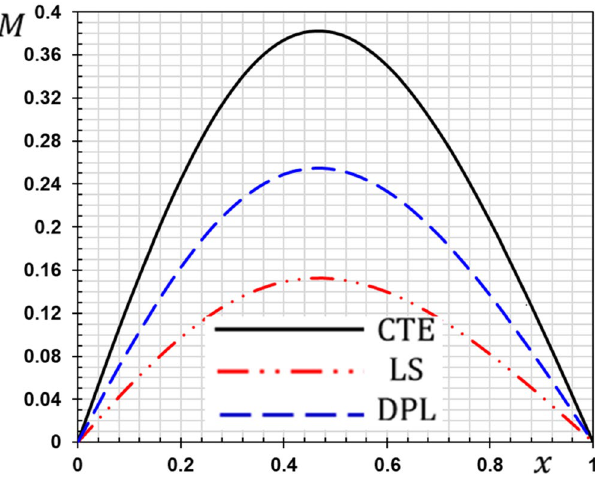
Figure 13. The flexure moment M with different thermoelastic